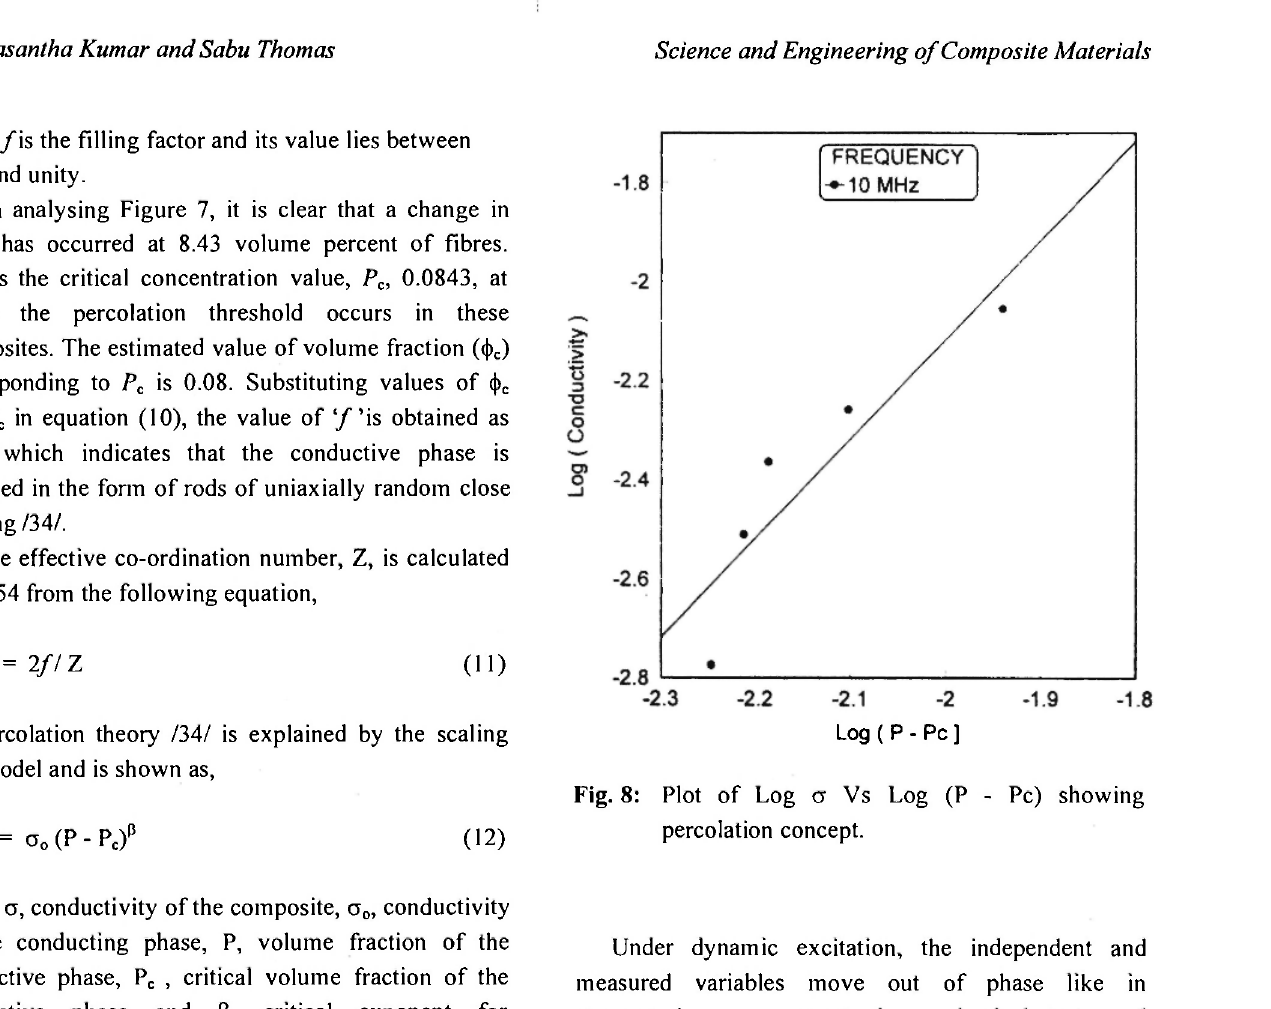
Fig. 8: Plot of Log σ Vs Log (P - Pc) showing percolation